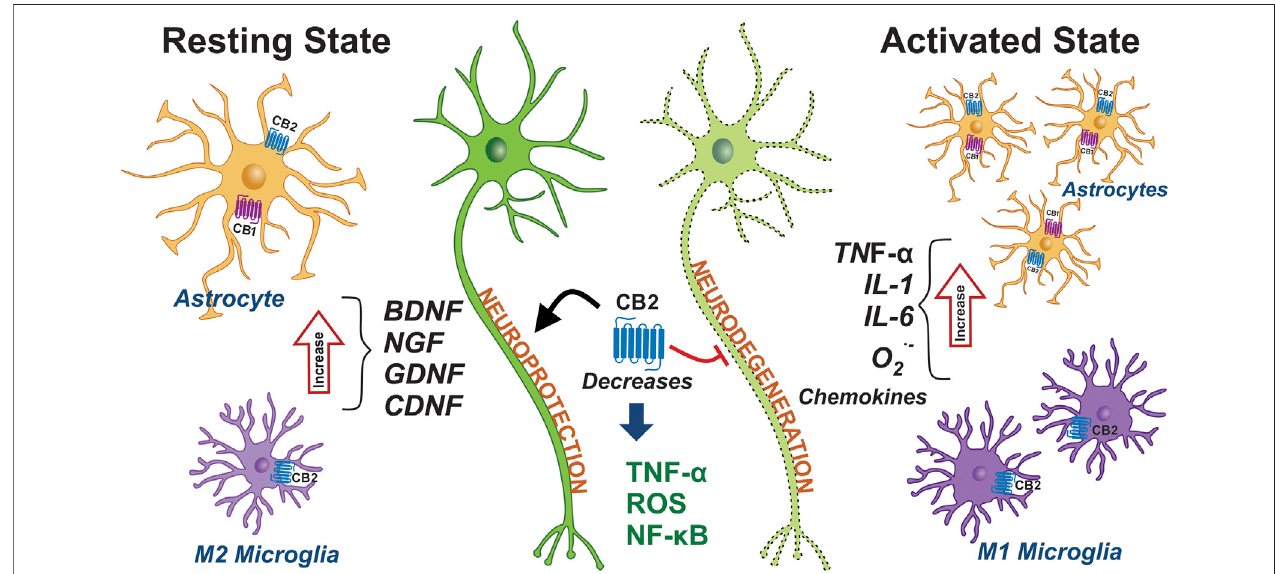
FIGURE5| Expressionofcannabinoid receptors inglialcellsand theirroleinPD. Thephenotypesofmicrogliaand astrocytes areschematicallyrepresented under non-in fl ammatory conditions, namely in a resting state. The microglia and astrocytes are shown in pro-in fl ammatory conditions and in an active state. The activation of microglia and astrocytes promotes and triggers the neuroin fl ammation that contributes to P D. The activation of the CB1 and CB2 receptors may decrease the in fl ammation seen in P D. Abbreviations: CB1, cannabinoid receptor type 1; CB2, cannabinoid receptor type 2; BDNF, brain-derived neurotrophic factor; NGF, nerve growth factor; GDNF, glial cell line-derived neurotrophic factor; CDNF, cerebral dopamine neurotrophic factor; ROS, reactive oxygen species; NF- κ B, nuclear factor kappa B; IL-1, interleukin-1; IL-6, interleukin-1; O 2 · - , Superoxide anion; TNF- α , tumor necrosis factor alpha.